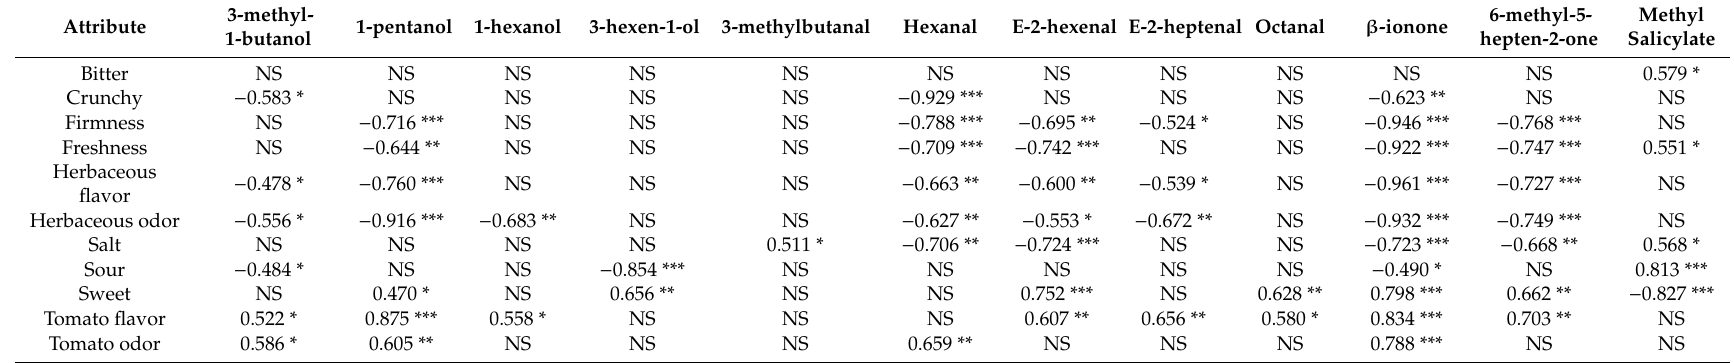
Table 7. Pearson’s product-moment correlation coe ffi cients (r) among volatiles concentration and sensory attributes. *, ** and *** indicate significance at p ≤ 0.05, 0.01 and 0.001, respectively. NS: not